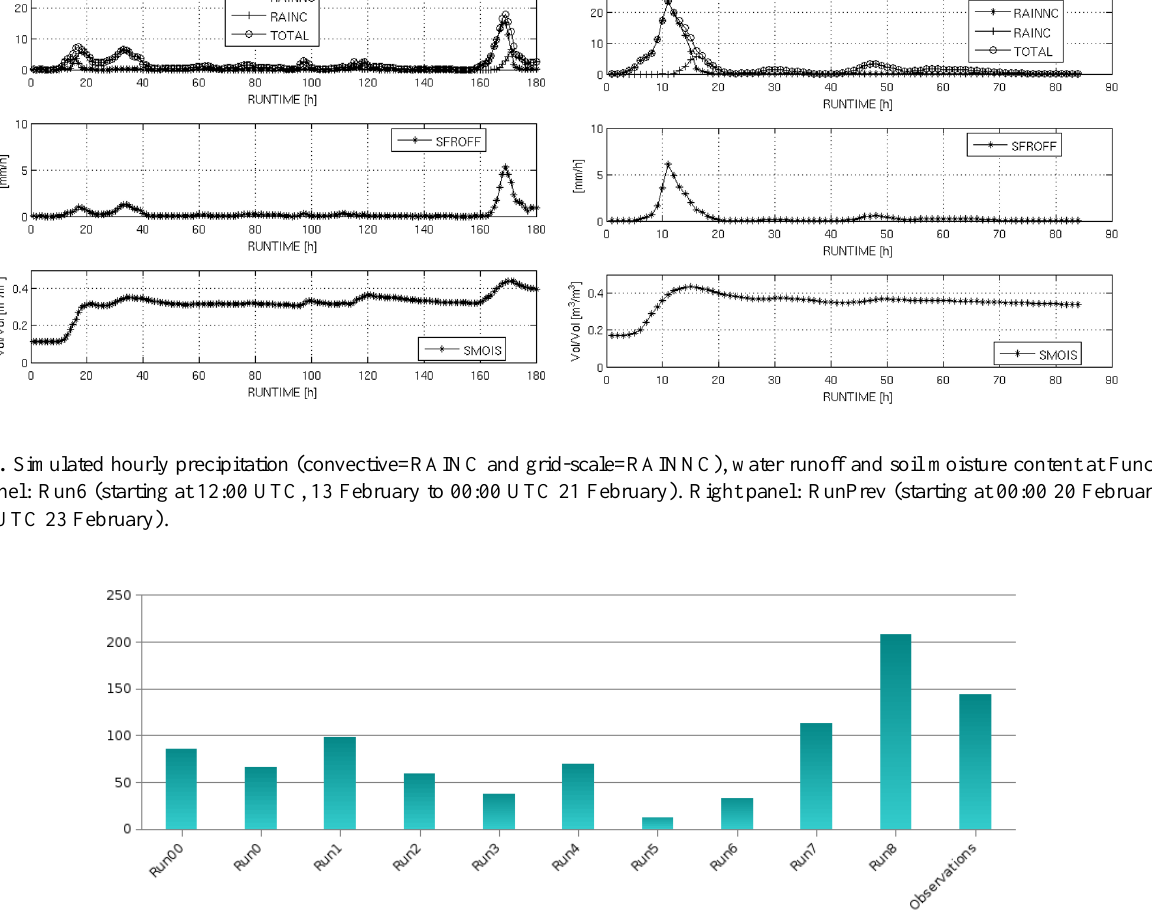
Fig. 14. Simulated hourly precipitation (convective=RAINC and grid-scale=RAINNC), water runoff and soil moisture content at Funchal. Left panel: Run6 (starting at 12H00 UTC, 13 th to 00H00 UTC 21 st of February). Right panel: RunPrev (starting at 00H00 20 th to 12H00 UTC 23 st of February).